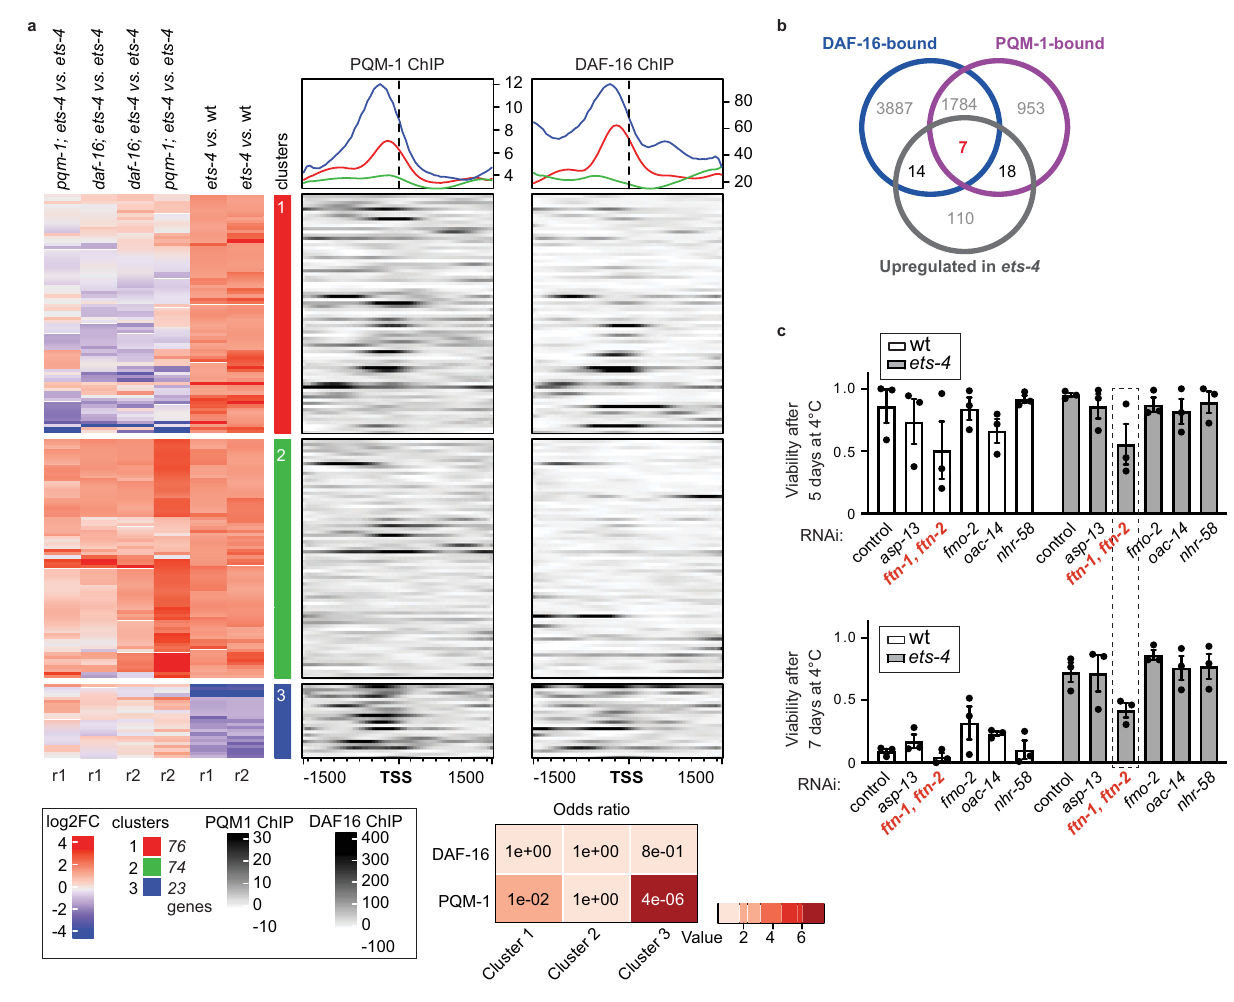
Fig. 4 | Identi fi cation of ftn-1 as a candidate gene promoting cold survival. a Heat map and clustering of genes differentially expressed in the cold. RNA-seq transcriptome analysis was performed on animals of the indicated genotypes: wt, ets-4(rrr16) , daf-16(mu86); ets-4(rrr16) , and pqm-1(ok485); ets-4(rrr16) . The animals, treated as in Fig. 1a, were collected on day 1 at 4°C. Left: Integrative heat map showinglog 2 foldchangesingeneexpressionbetweentheindicatedstrains. “ r1and r2 ” indicate biological replicates. Each line represents one gene. Automated clus- teringshowedthreedistinctclusters:cluster1(red),cluster2(green),andcluster3 (blue). Right: binding of DAF-16 and PQM-1 around the transcription start sites (TSSs) of genes shown on the left, using the ChIP ENCODE data 34 . The line graphs above(coloredaccordingtotheclusters)illustrateenrichmentsforDAF-16orPQM- 1 binding, within each cluster, around the TSS. The heat map below shows a hypergeometrictestofoverlapsbetweenthreeclustersofgenesandPQM-1orDAF-